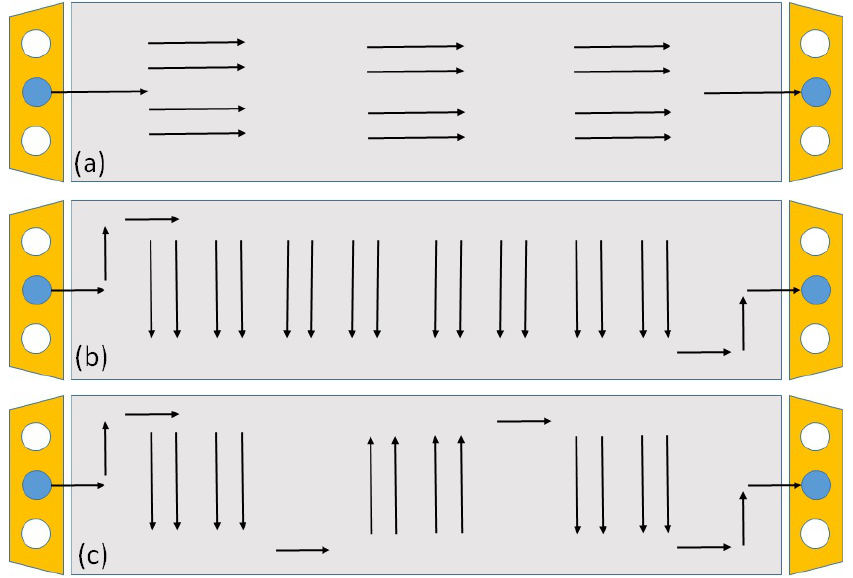
Figure 4. Coolant flow configuration. ( a ) In flow direction of hydrogen and air, ( b ) in cross-flow, and ( c ) cross-flow in separated blocks.